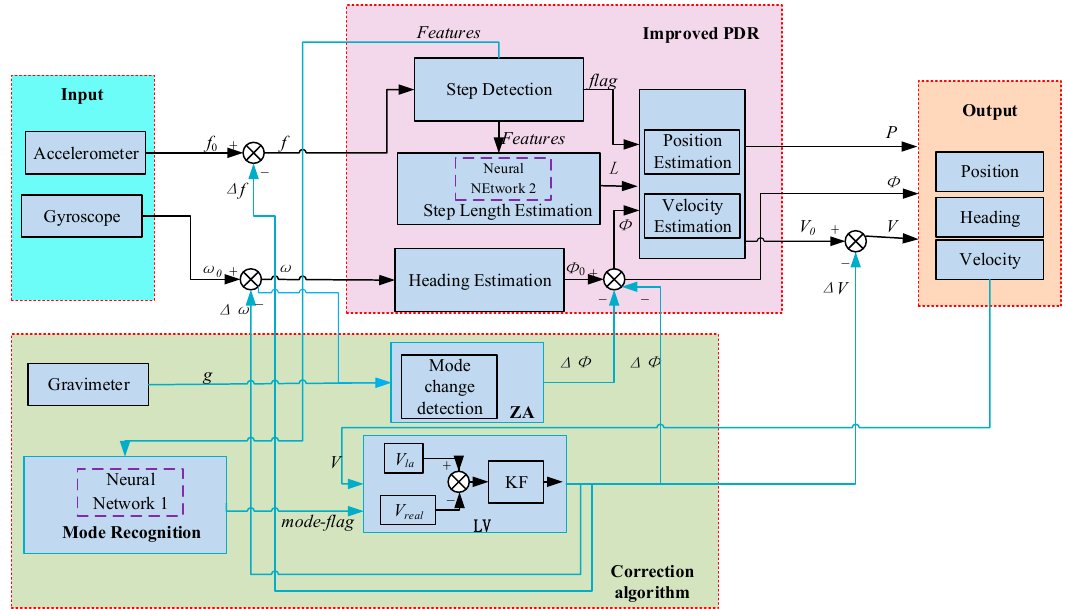
Figure 2. The scheme of the proposed novel PDR algorithm.